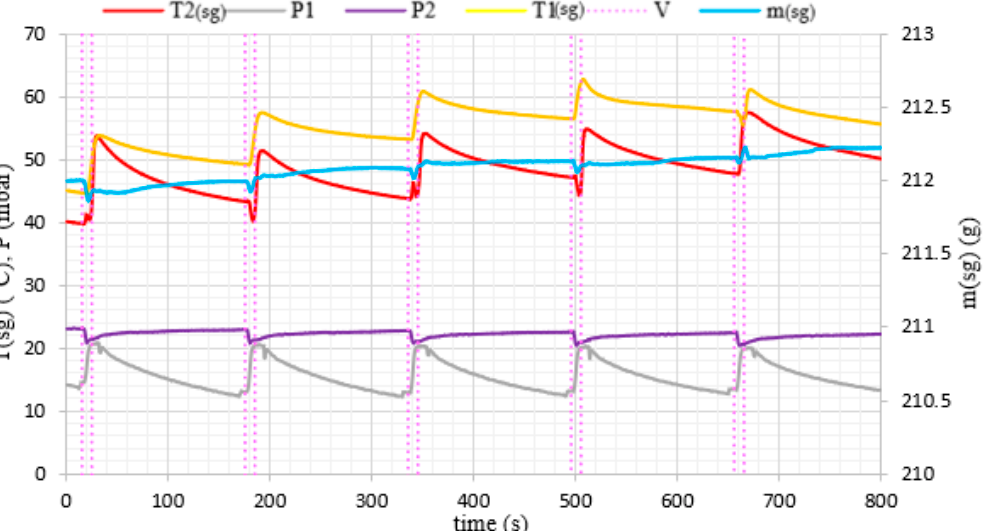
Figure 11. The changes of pressure, temperature and mass of evaporated water with time profiles in the adsorption chamber corresponding to fluidized bed conditions (Irregular SG from Sigma Aldrich).